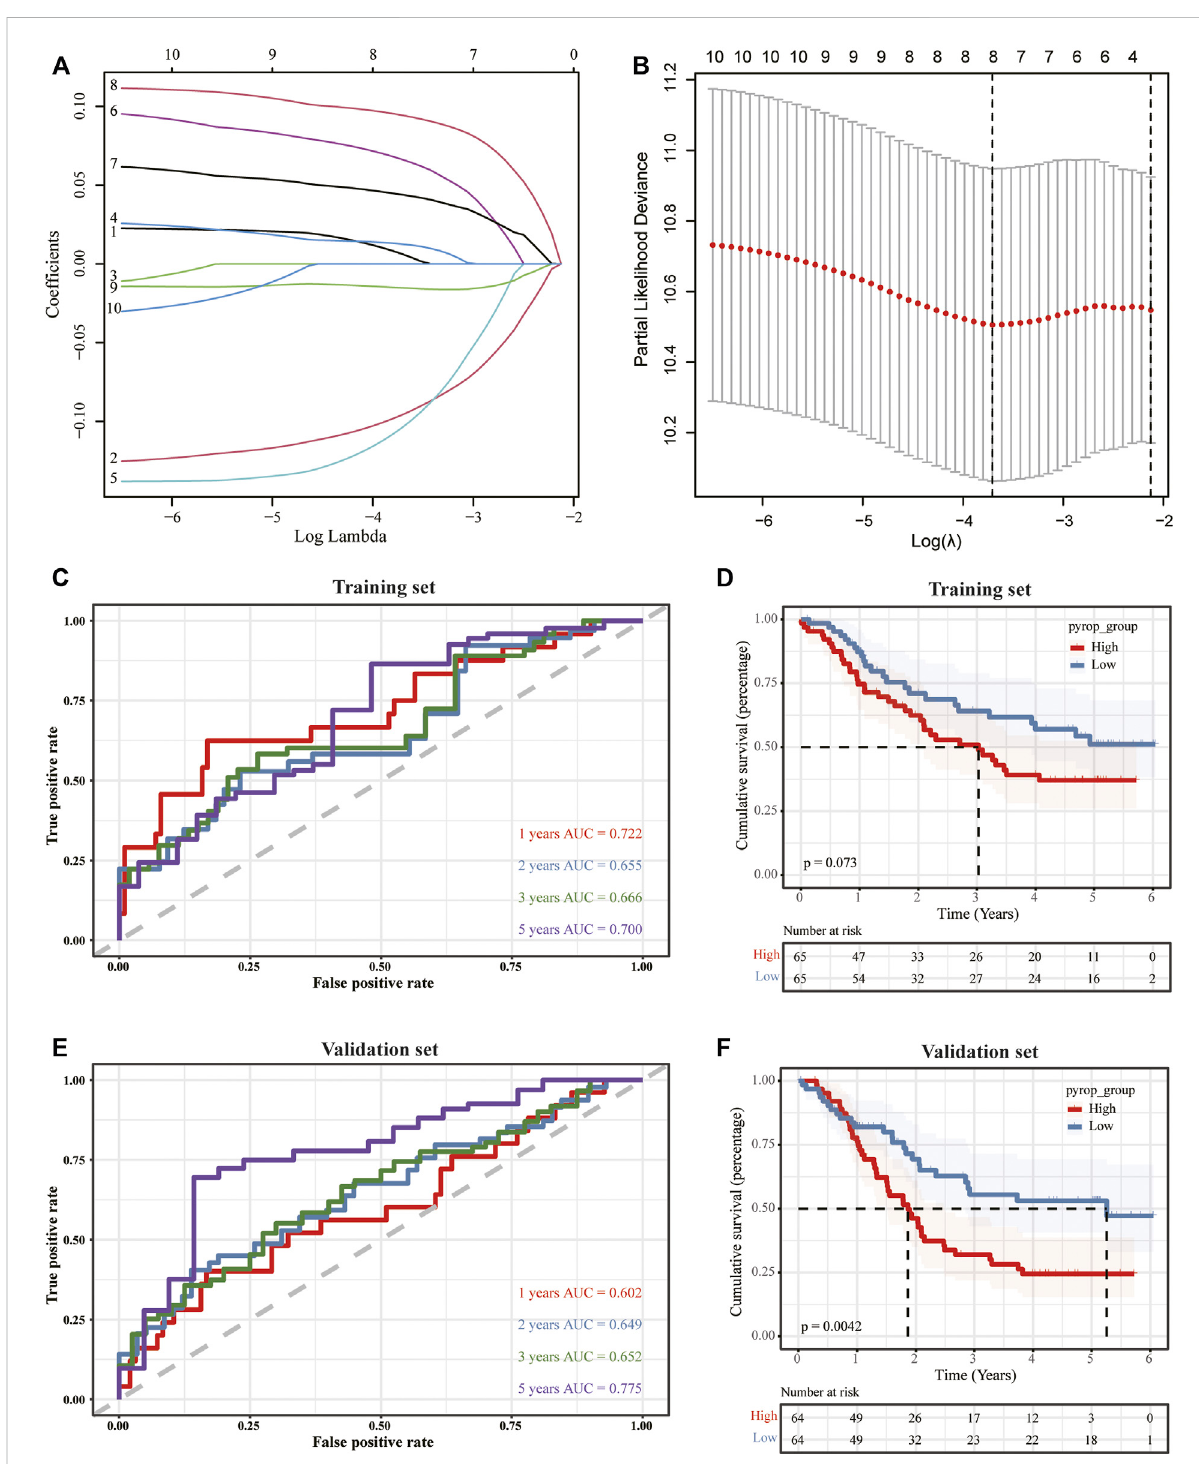
FIGURE 6 Theconstructionofapyroptosisscoringmodel. (A,B) Lassoanalysiswasperformedtoobtainthepyroptosis-related genesfortheconstruction of the pyroptosis scoring model. (C) TimeROC curves of the pyroptosis scoring model in the training set. (D) The impact of the pyroptosis scoring model on OS in the training set. (E) TimeROC curves against the pyroptosis scoring model in the validation set. (F) Survival analysis of the pyroptosis scoring model in the validation